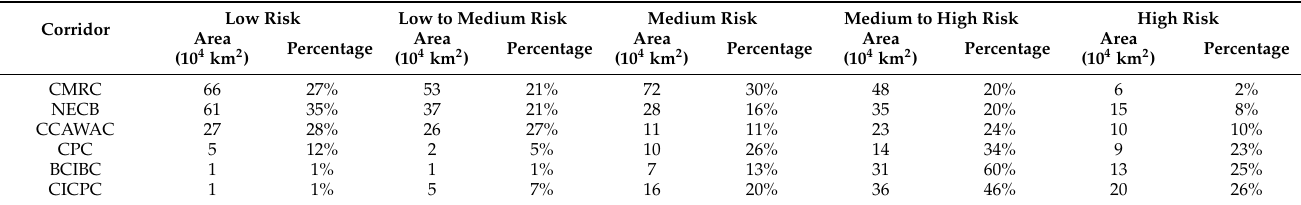
Table 8. Potential impact corridor area along the “Belt and Road” zone by water hazard.